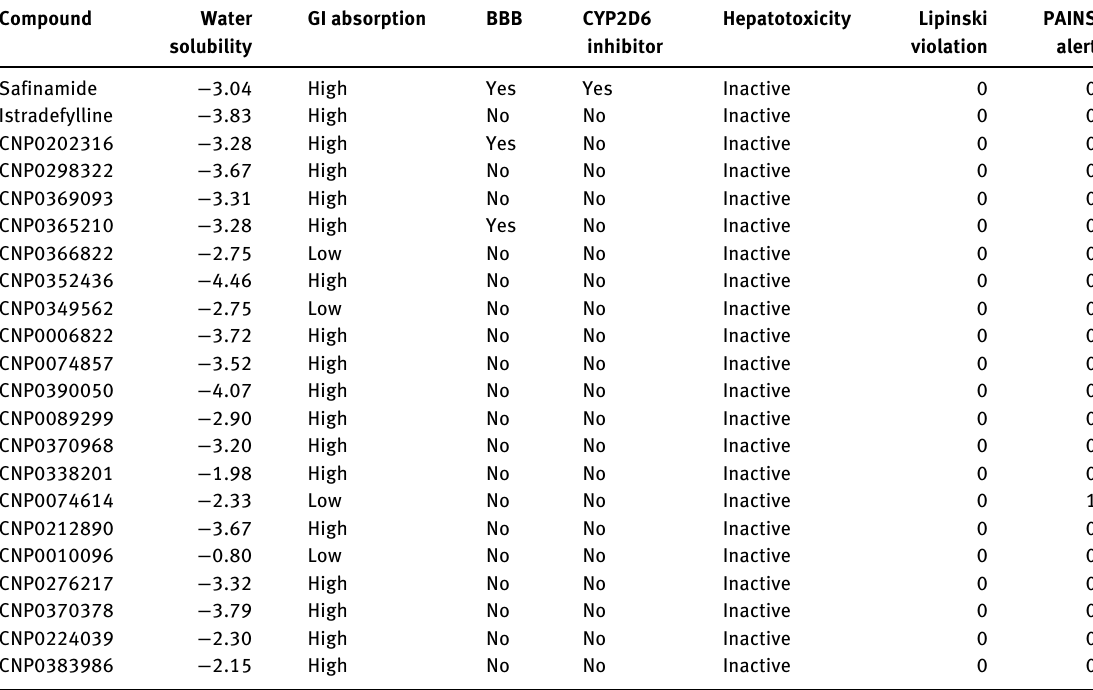
Table 2: Pharmacokinetics, toxicity prediction and drug likeness of the selected compounds. Compound